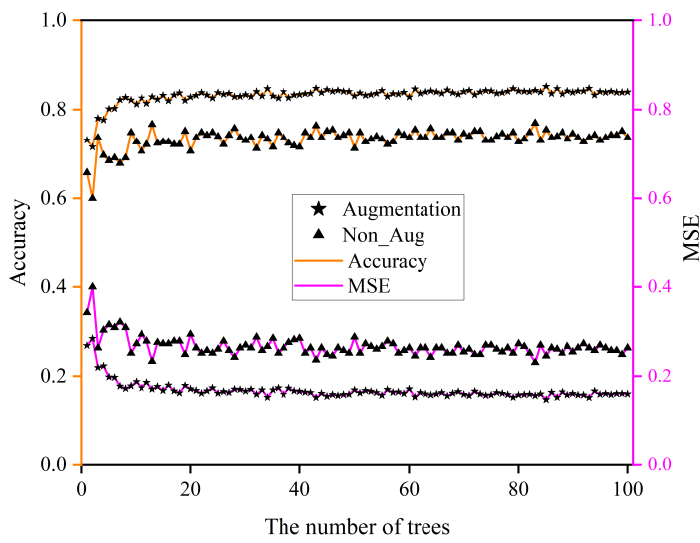
Figure 13. The MSE and accuracy of a random forest model in a different number of trees. Table 4. The performance measures of all algorithms using data augmentation.